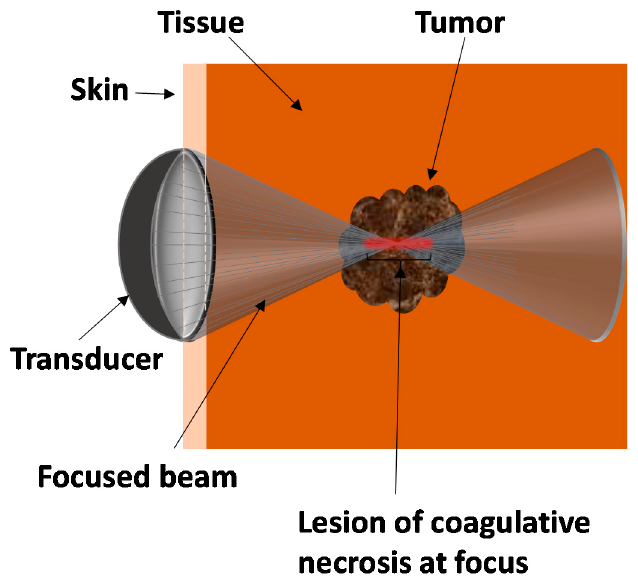
Figure 1. Overview schematic of high-intensity focused ultrasound for tumor therapy.